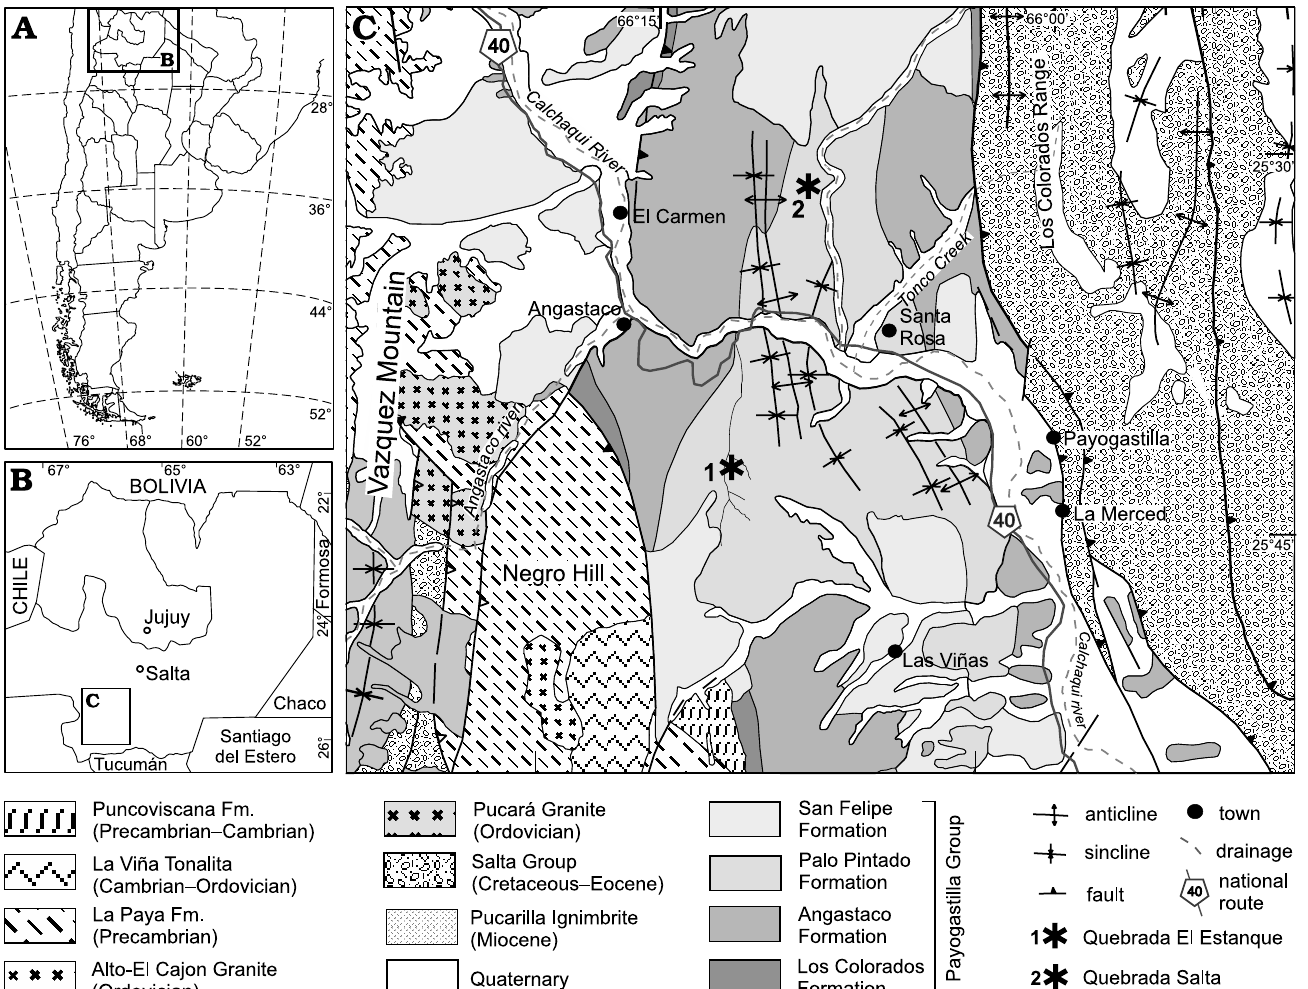
Fig. 1. A , B . Map showing location of the study area within Argentina. C . Geological map with indicated fossil localities of Quebrada El Estanque and Quebrada